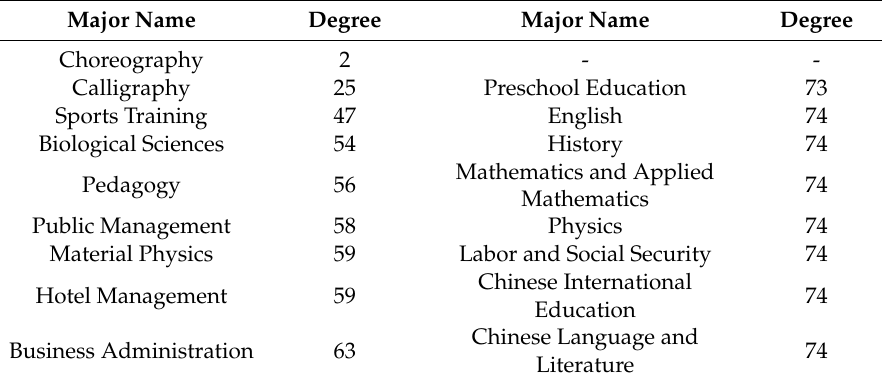
Table 5. Values of major node